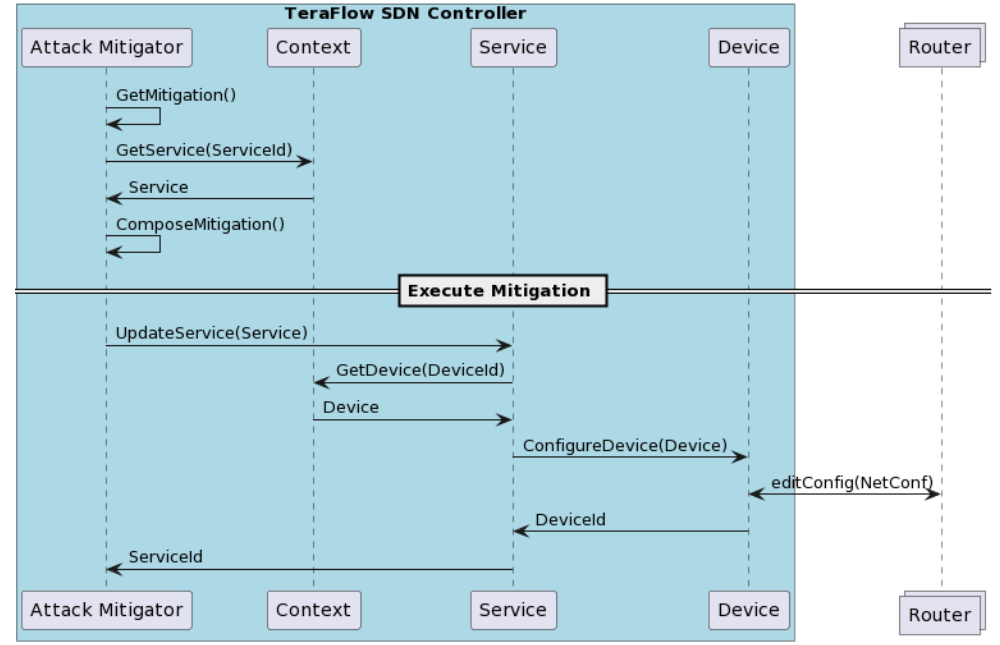
Figure 6. Attack Mitigator component